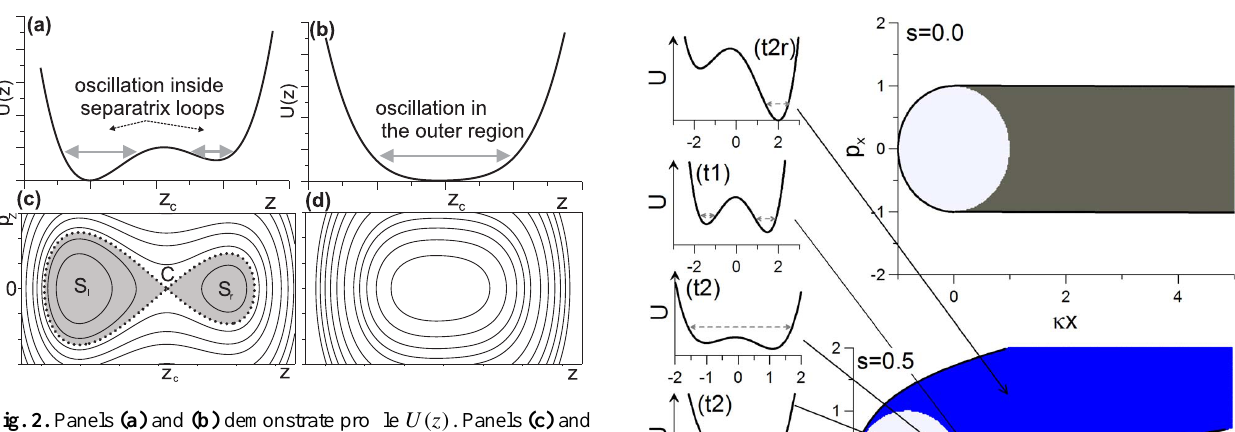
Fig. 2. Panels (a) and (b) demonstrate profile U(z) . Panels (c) and (d) demonstrate the corresponding phase plane of the fast variables. S l and S r are the areas surrounded by separatrix loops.